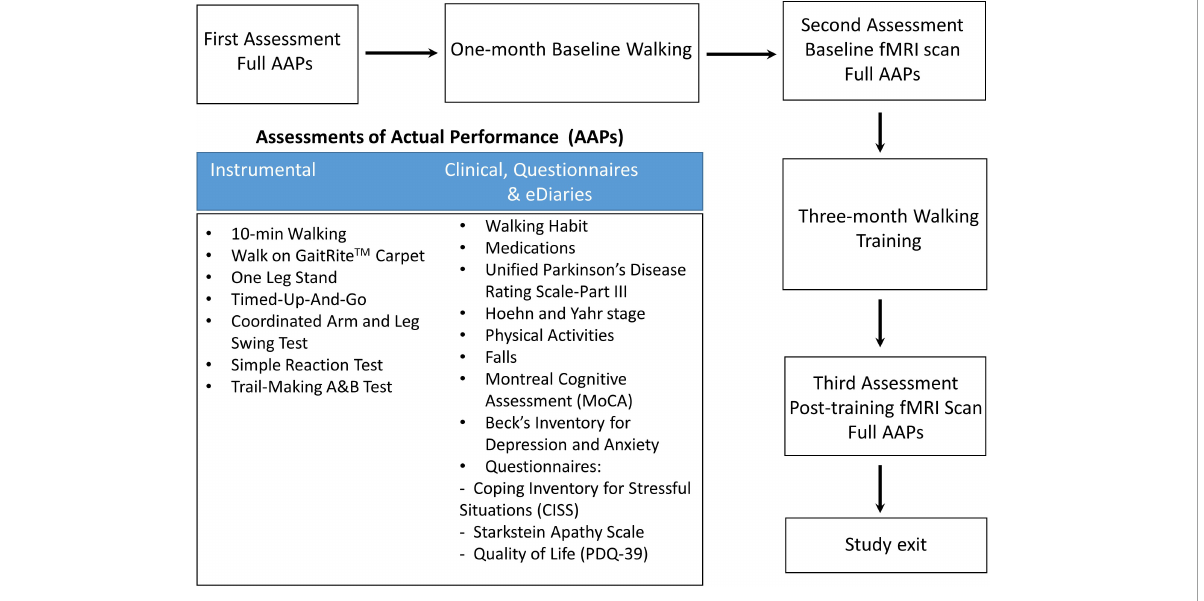
FIGURE1 Flowchart for the study protocol.